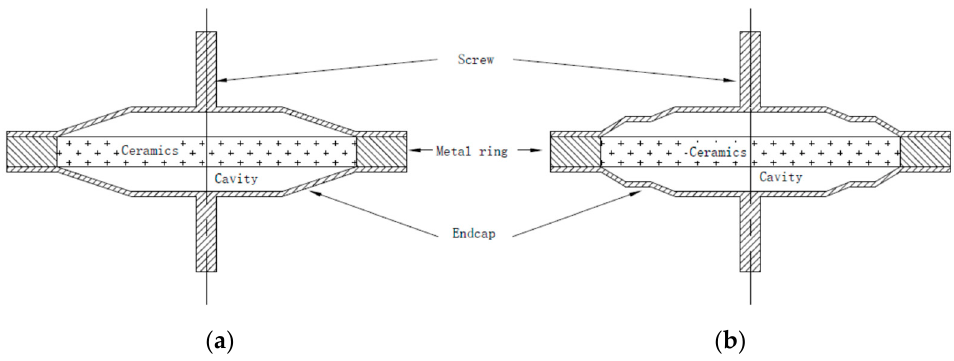
Figure 8. Structures of PTA and PTB. ( a ) PTA structure. ( b ) PTB structure.